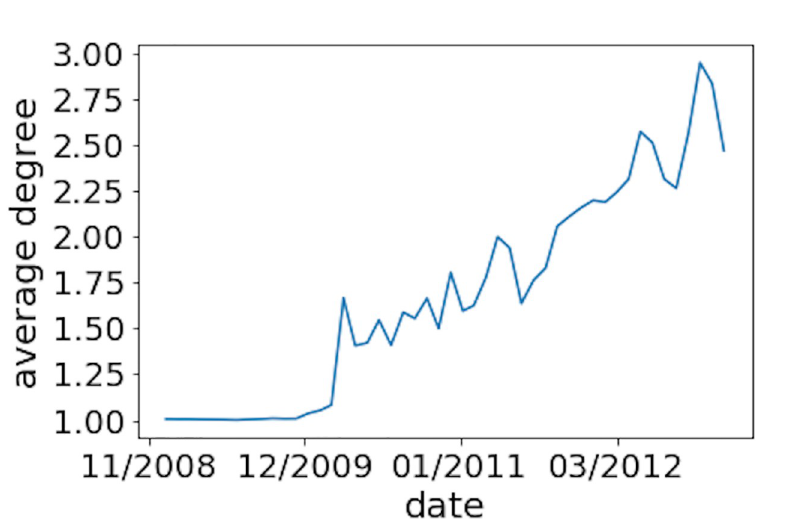
Fig 3. Evolution of the monthly network average degree. We observe that the average degree of the network grows steadily with time.